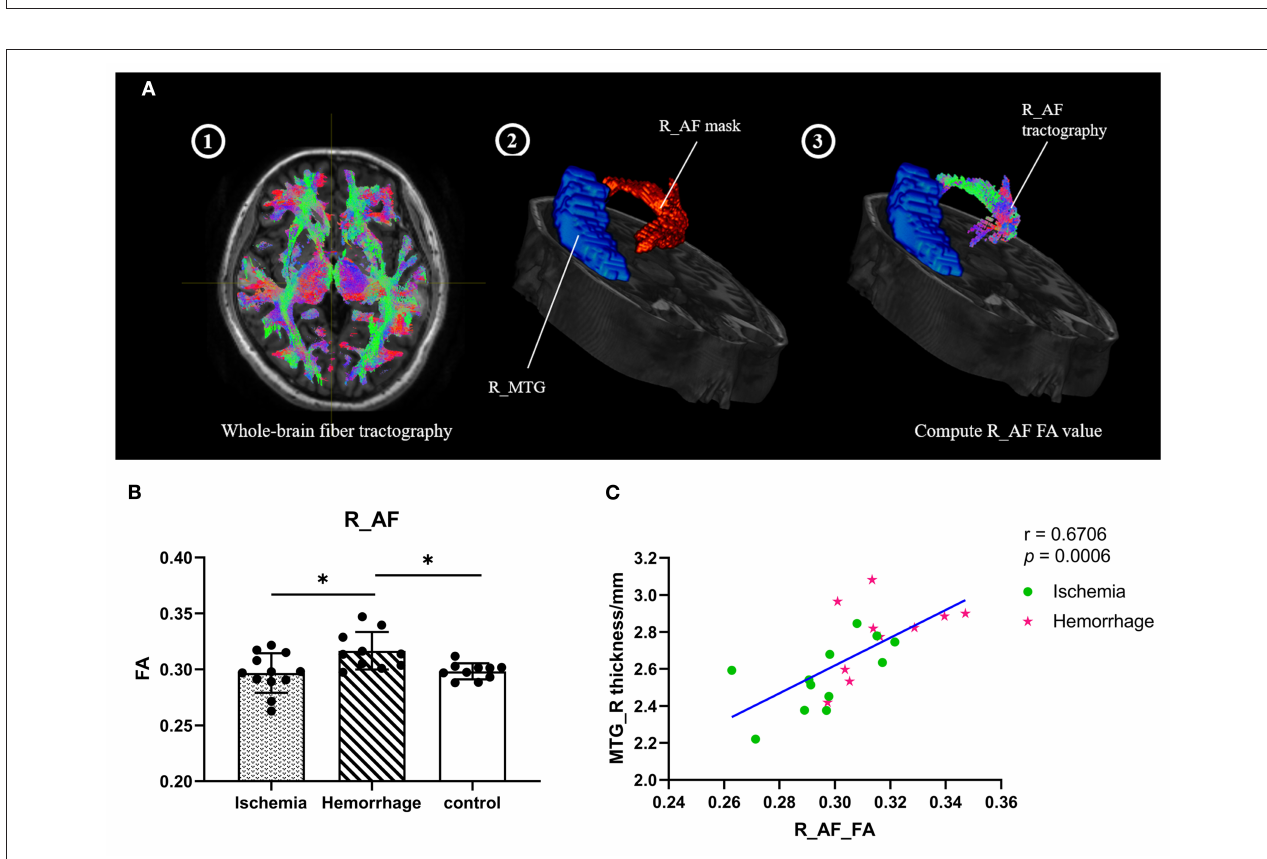
FIGURE 4 | (A) Process of computing the FA values of fiber tracts (take the right AF as an example). Step 1: Perform the subject’s whole-brain fiber tractography by MRtrix3; Step 2: Overlay the right AF mask; Step 3: Create the right AF tractography and compute the FA values. (B) FA values of the right AF between three groups. (C) Correlation between the cortical thickness of right MTG and the FA values of right AF within patients with MMD. L means left hemisphere. R means right hemisphere. AF, arcuate fasciculus; MTG, middle temporal gyrus; FA, fractional anisotropy. * p < 0.05.